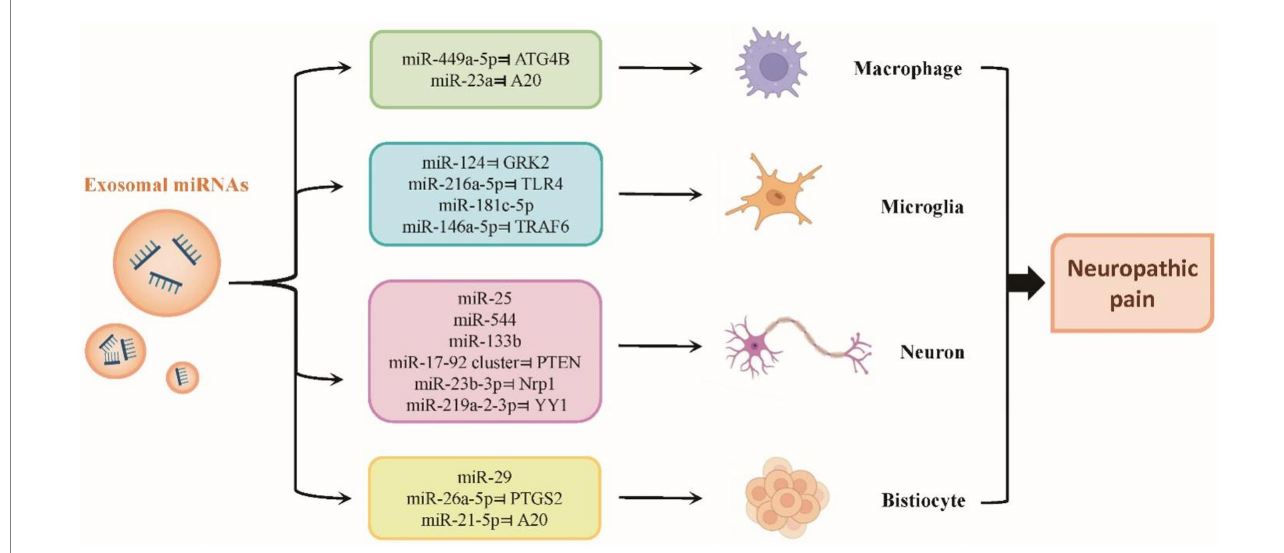
FIGURE 3 Roles of exosomal miRNAs in neuropathic pain. Exosomal miRNAs can be transported to different sites after autocrine production, acting on macrophages, microglia, neurons or other tissue cells, and regulate the process of neuropathic pain by participating in the secretion of inflammatory factors, and oxidative stress, and regulating neural remodelling or nerve